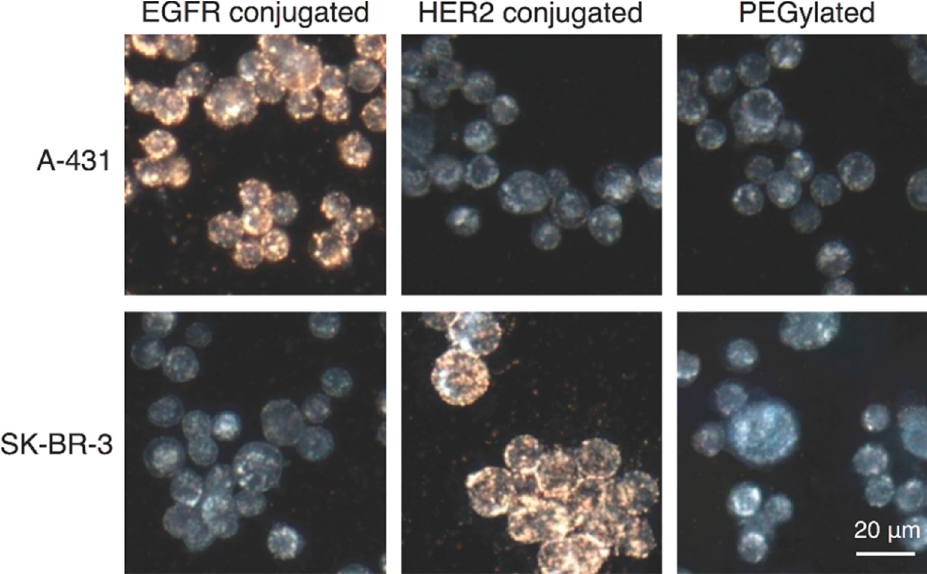
Figure 9. Cancer cells labelled with nanoclusters imaged using dark field reflectance. Dark blue-greyish cells are unlabelled. It can be seen that the antigen labelled nanoclusters are only taken up into cells with the complementary antibody. Reprinted with permission from [40]. Copyright WILEY-VCH, 2014.